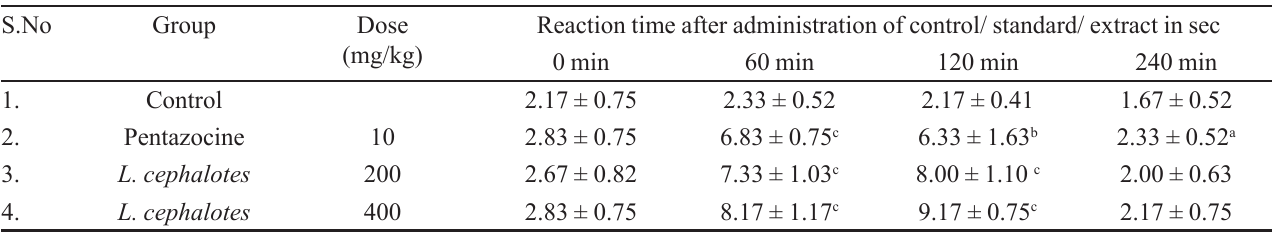
TABLE I - Effect of methanolic extract from L. cephalotes on the hot plate test in mice S.No